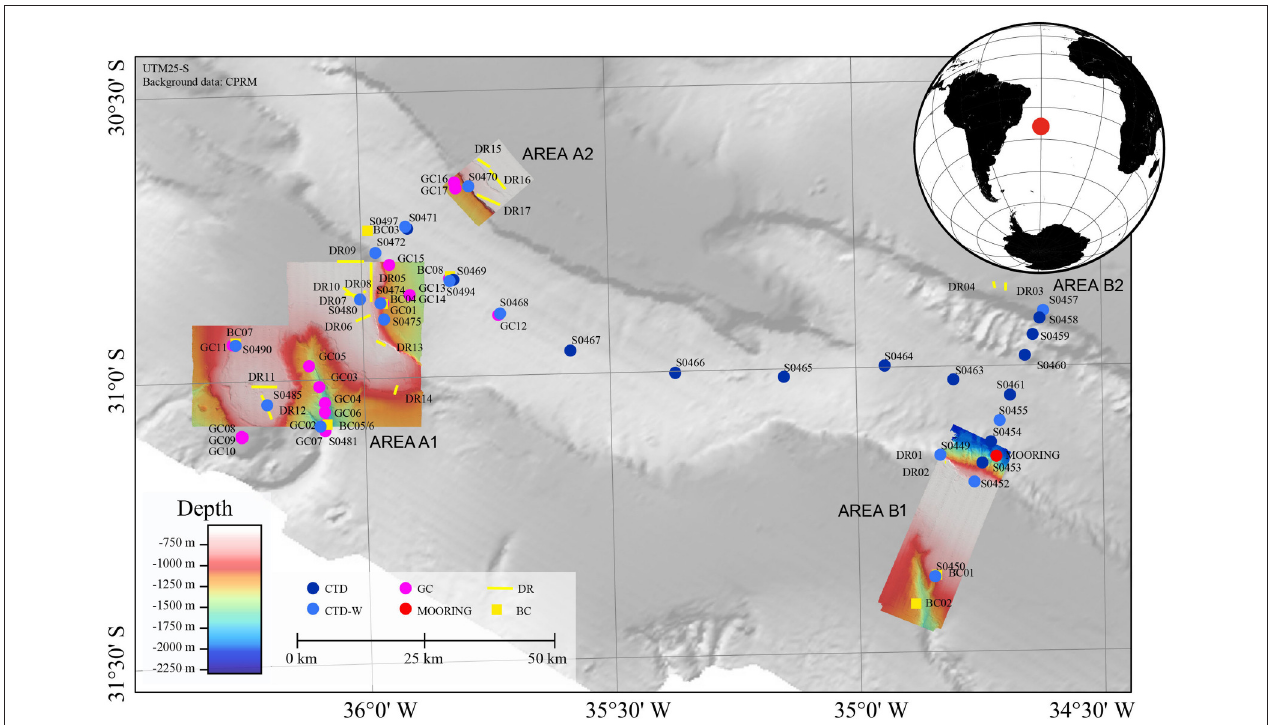
FIGURE 1 | Location map of the operations performed during the oceanographic expedition RGR1 to Rio Grande Rise on board the research vessel Alpha Crucis (Universidade de São Paulo). High resolution bathymetry was performed during the cruise. GC, gravity corer; DR, dredge; BC,